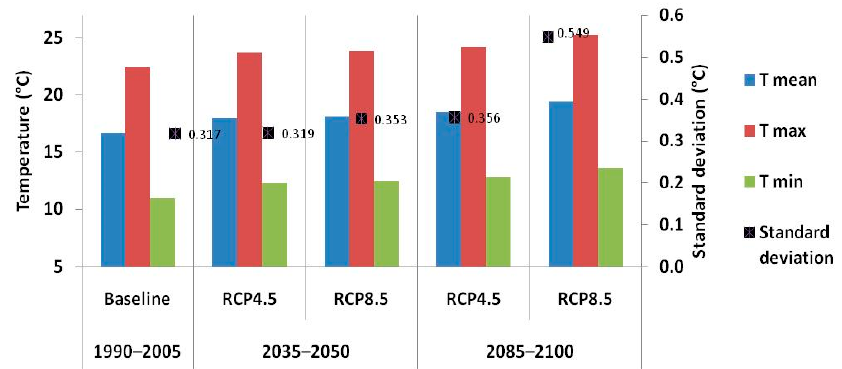
Figure 5. Averages of daily temperatures during simulation periods under baseline, RCP4.5, and RCP8.5, as well as values of year-to-year standard deviation.